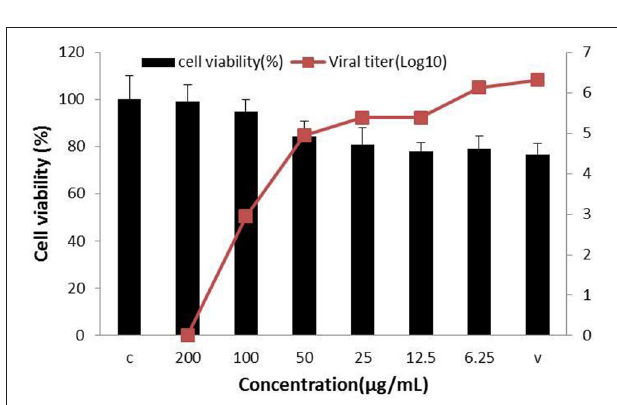
FIGURE 4 | Ginsenoside Rb3 antiviral activity against bovine viral diarrhea virus (BVDV). All serial dilutions Rb3 concentrations were used and uninfected and virus infected cells were